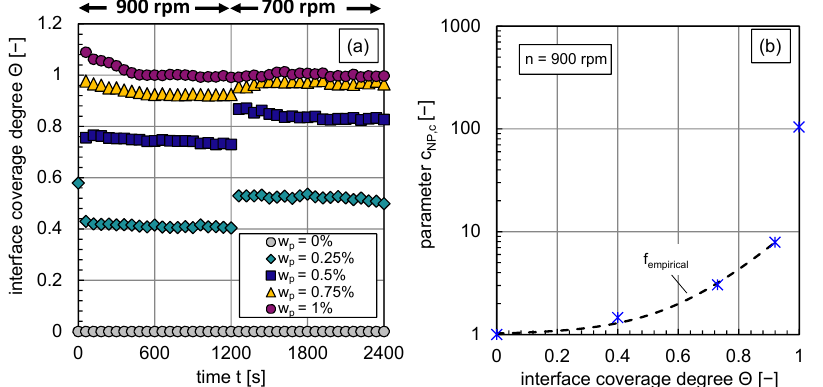
Figure 7. ( a ) Transient calculated interface coverage degree for w p = 0–1% before and after an abrupt stirrer speed decrease at t = 1160 s, ( b ) fitted parameter c np , c as a function of the coverage degree Θ by particles at n = 900 rpm (blue stars), fitted curve (black dotted line) f empricial for interface coverage degrees lower